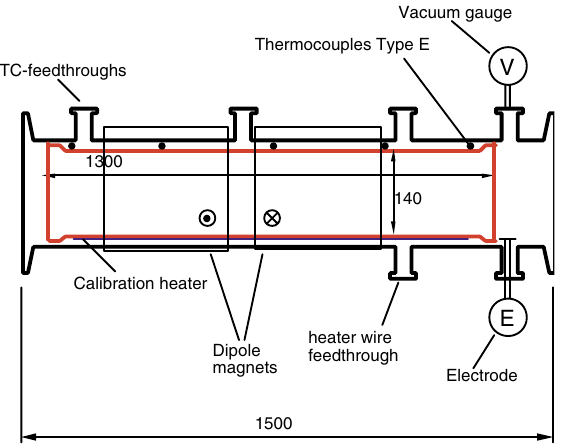
FIG. 2. (Color) Schematic of the WAMPAC